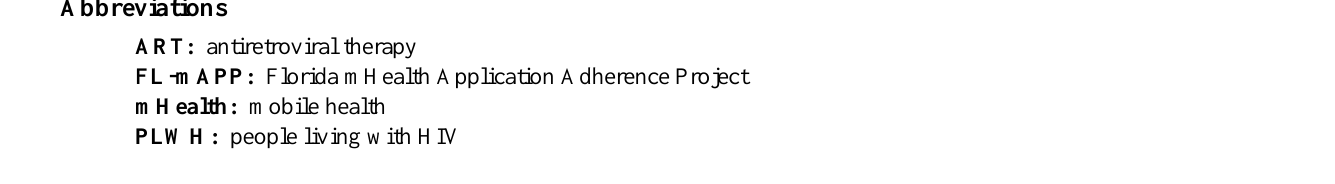
ART: antiretroviral